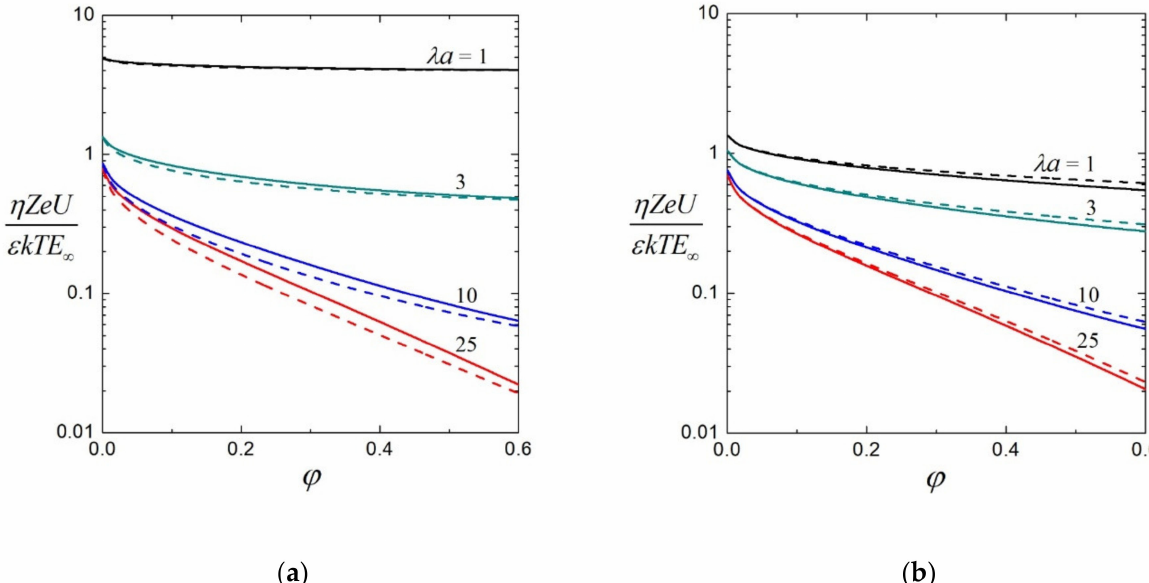
Figure 6. Scaled electrophoretic mobility η ZeU / ε kTE ∞ versus ϕ for a suspension of soft spheres with Q = 4: ( a ) r 0 / a = 0 (porous spheres) with the solid and dashed curves representing calculations for the Happel and Kuwabara models, respectively; ( b ) r 0 / a = 1/2 for the Happel model with the solid and dashed curves denoting results obtained from conditions (13) and (14), respectively, at the cell